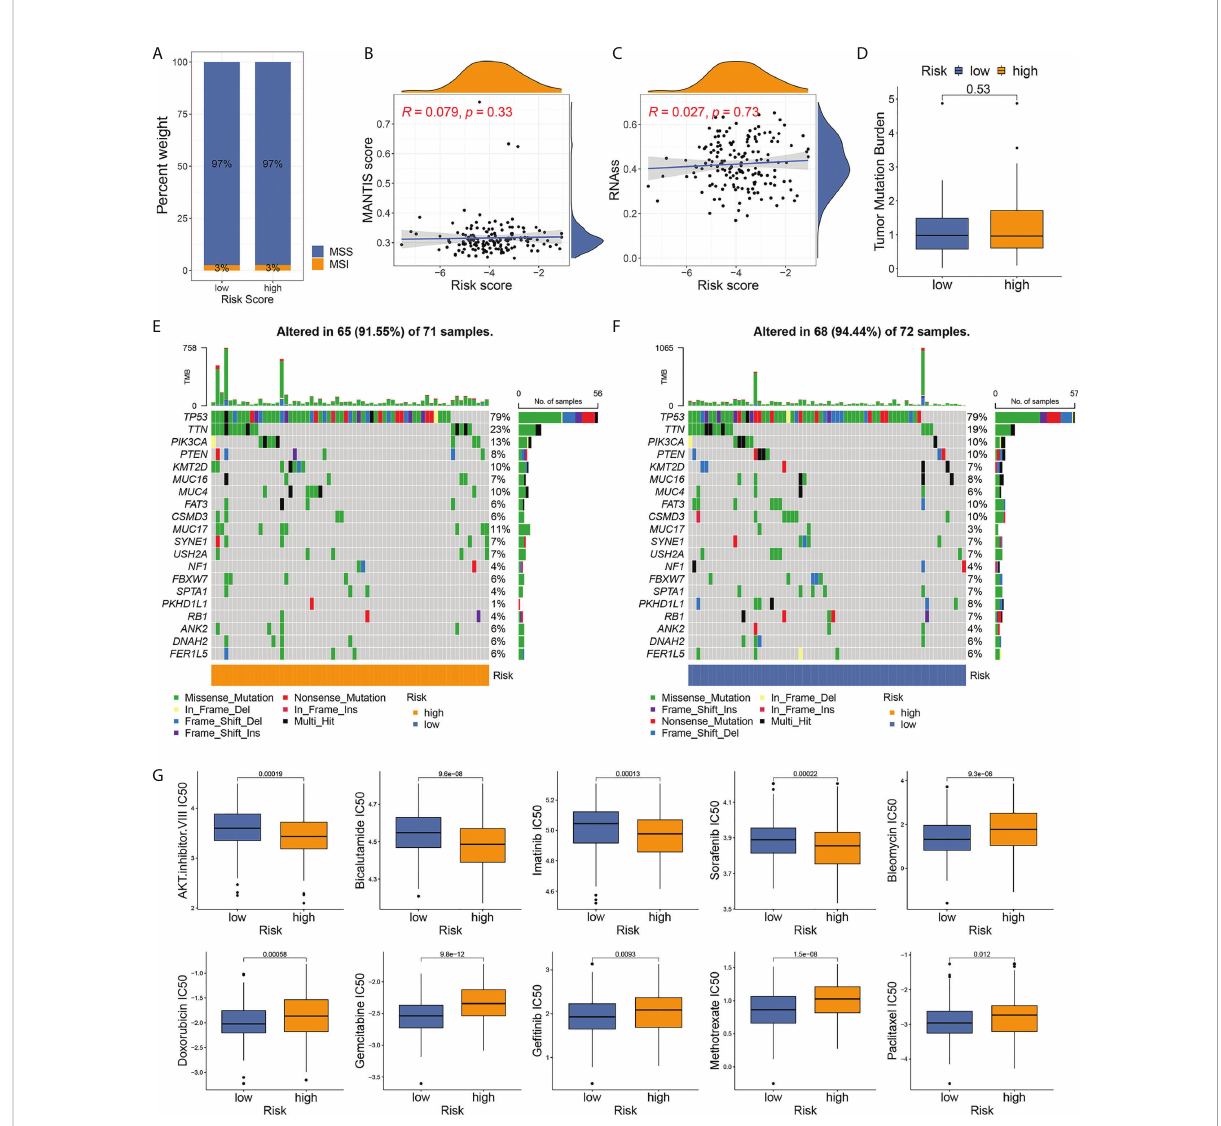
FIGURE 7 Analyses of microsatellite instability, somatic mutation, and drug susceptibility based on risk strati fi cation. (A) Distribution of MSI incidence among high- and low-risk patients. (B) Correlation between MSI score and risk score of TNBC samples. (C) Correlation between RNA stemness score and risk score. (D) Comparison of TMB between risk groups. (E, F) Somatic mutation frequencies in high- and low-risk TNBC tumors. (G) Drug susceptibility analyses (IC50) of commonly used chemotherapy reagents between high- and low-risk